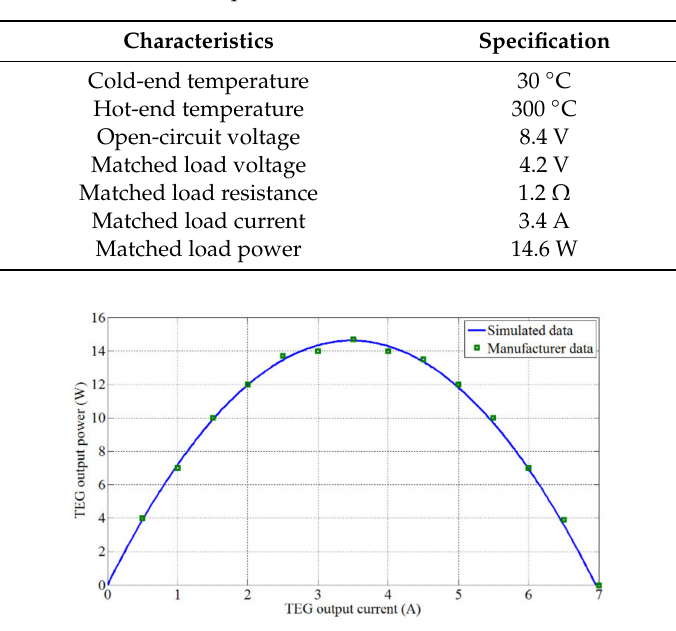
Table 1. Specifications of TEG1-12611-6.0.